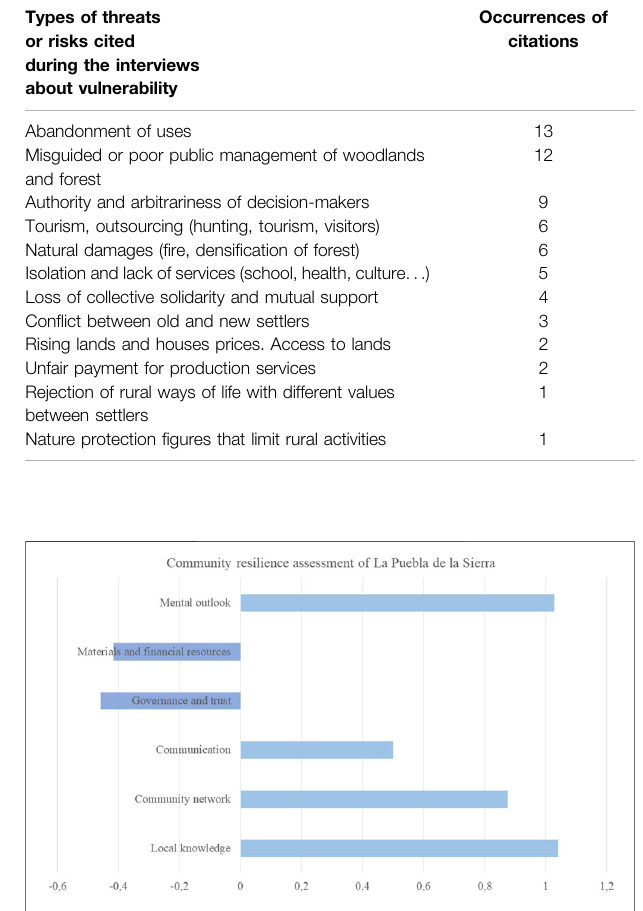
Frontiers in Environmental Science |